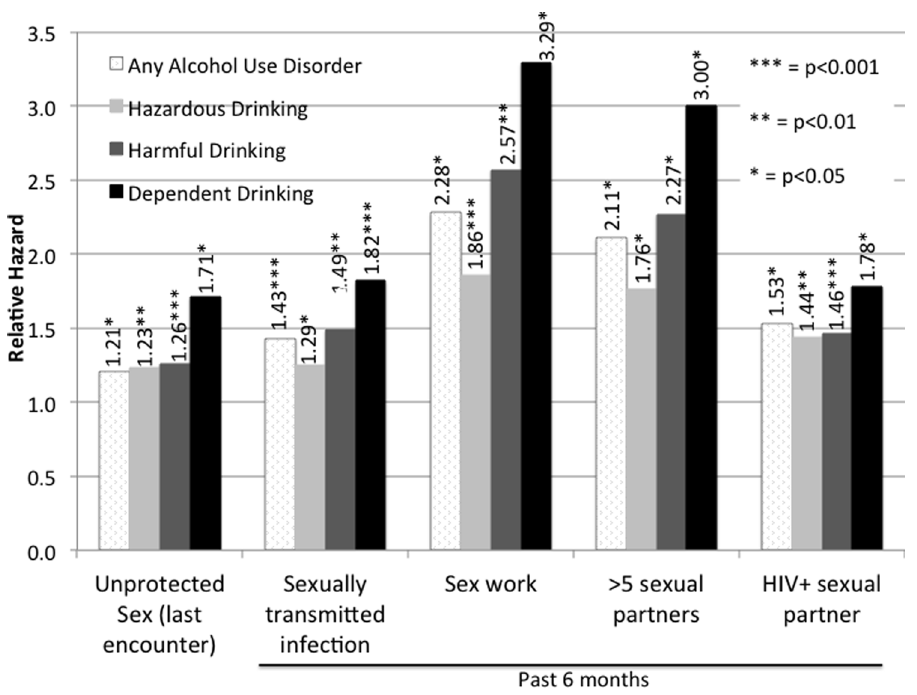
Figure 1. Bivariate correlation between alcohol use disorders and alcohol use severity and high-risk HIV risk behaviors.